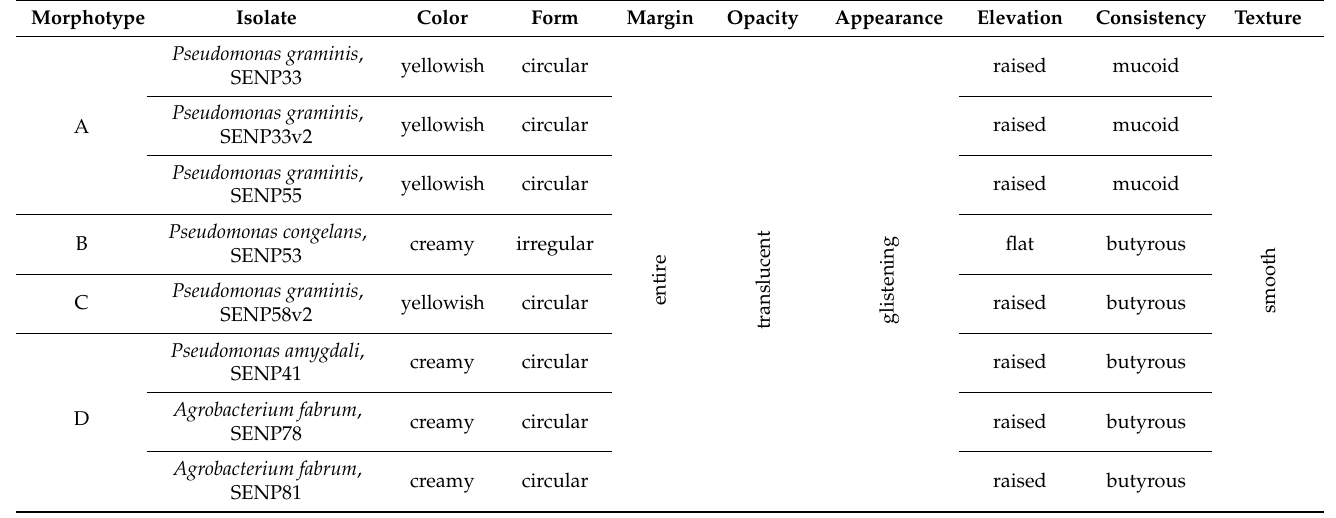
Table A2. Colony morphology of the bacterial isolates